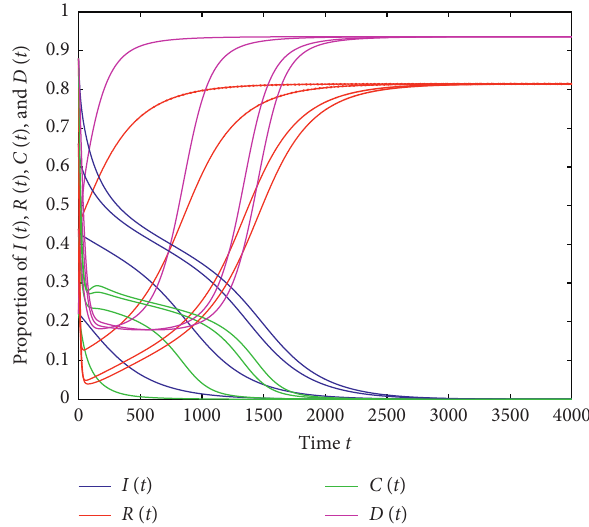
Figure 4: Stability of the attack-free solution E